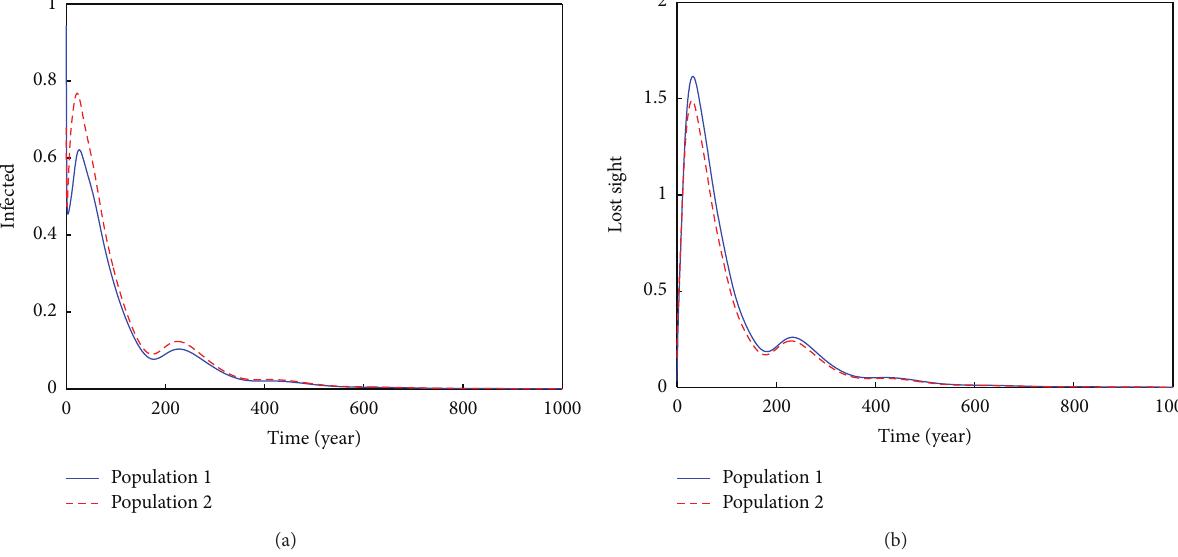
Figure 4: Trajectories of infectious individuals in care center (a) and lost sight individuals (b) of (1) for different initial conditions when = 0.002 and 𝛽 = 0.003 (such that 𝑅 1 = 0.3691 and 𝑅 2 = 0.4980 ). The infectious and lost sight classes disappear at the end and only 𝛽 1 2 0 0 susceptible classes persist when 𝑅 0 < 1 . All other parameters are as in Table